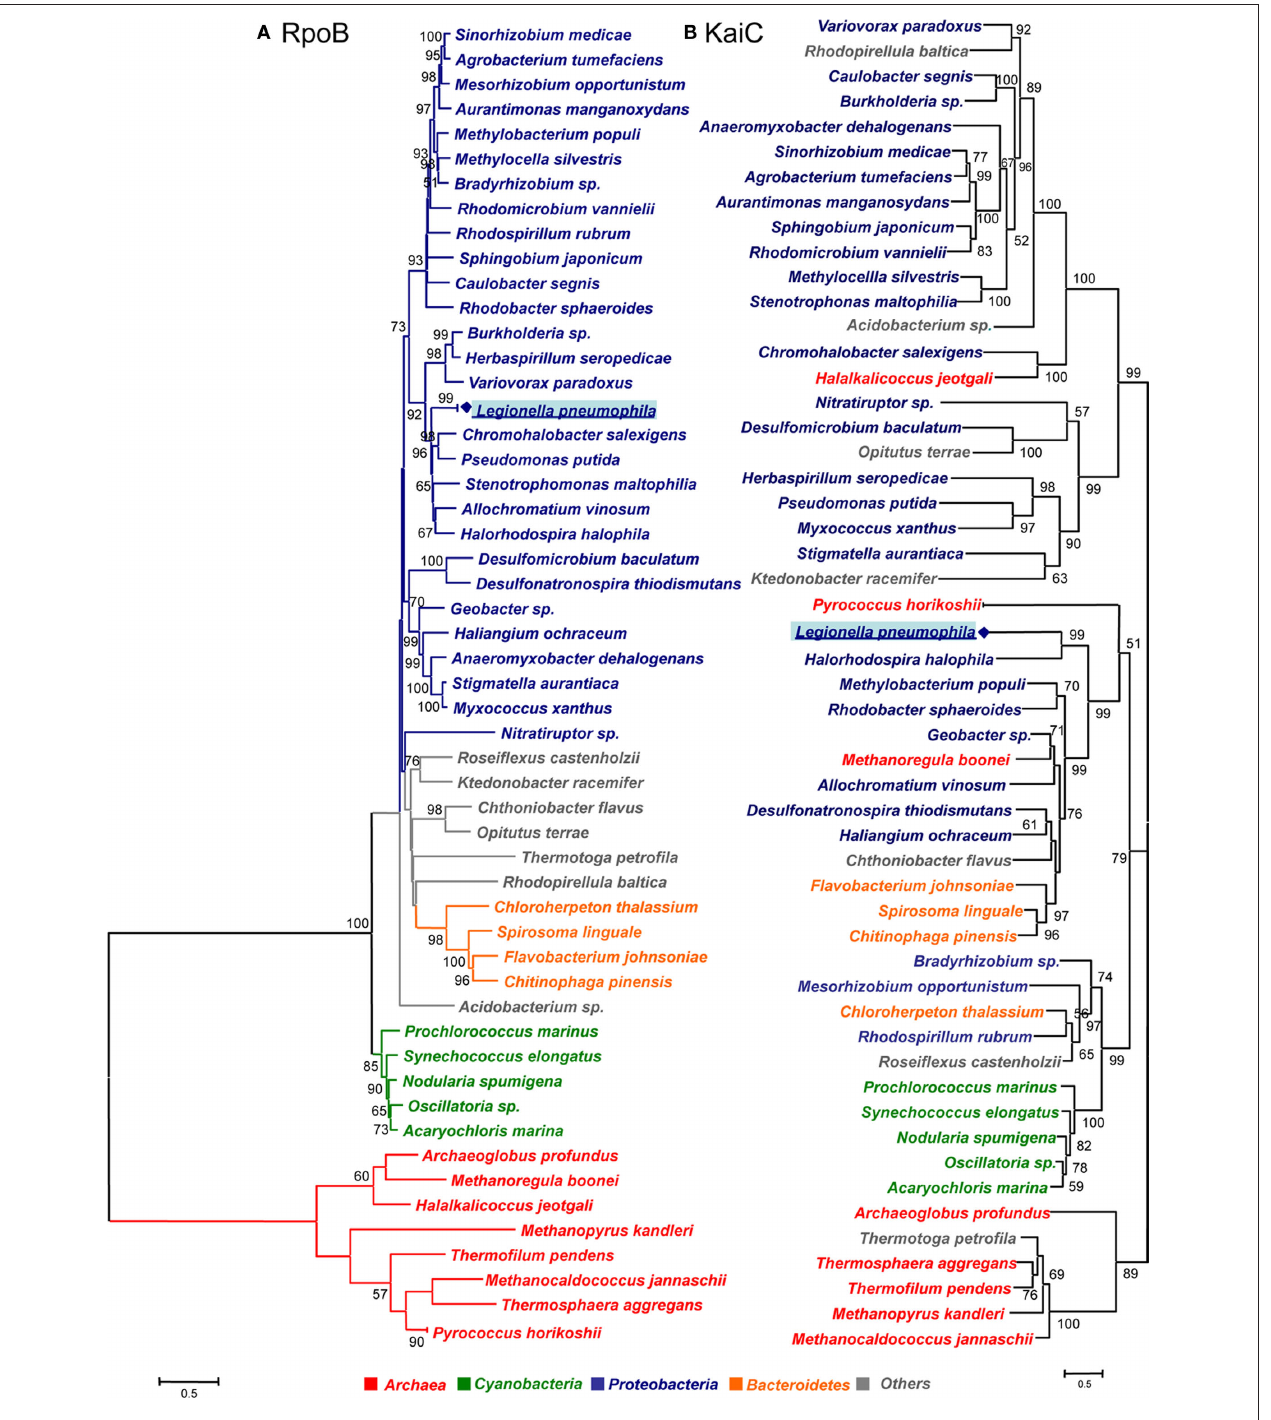
Figure 3 | Phylogenetic tree of rpoB and kaiC sequences of prokaryotes containing kaiB and kaiC in their genome. (A) RpoB amino acid sequence tree obtained by the neighbor-joining method. (B) KaiC amino acid sequences obtained by the likelihood method. The bootstrap values presented at corresponding nodes were obtained from 300 replicates. Values under 50 are not